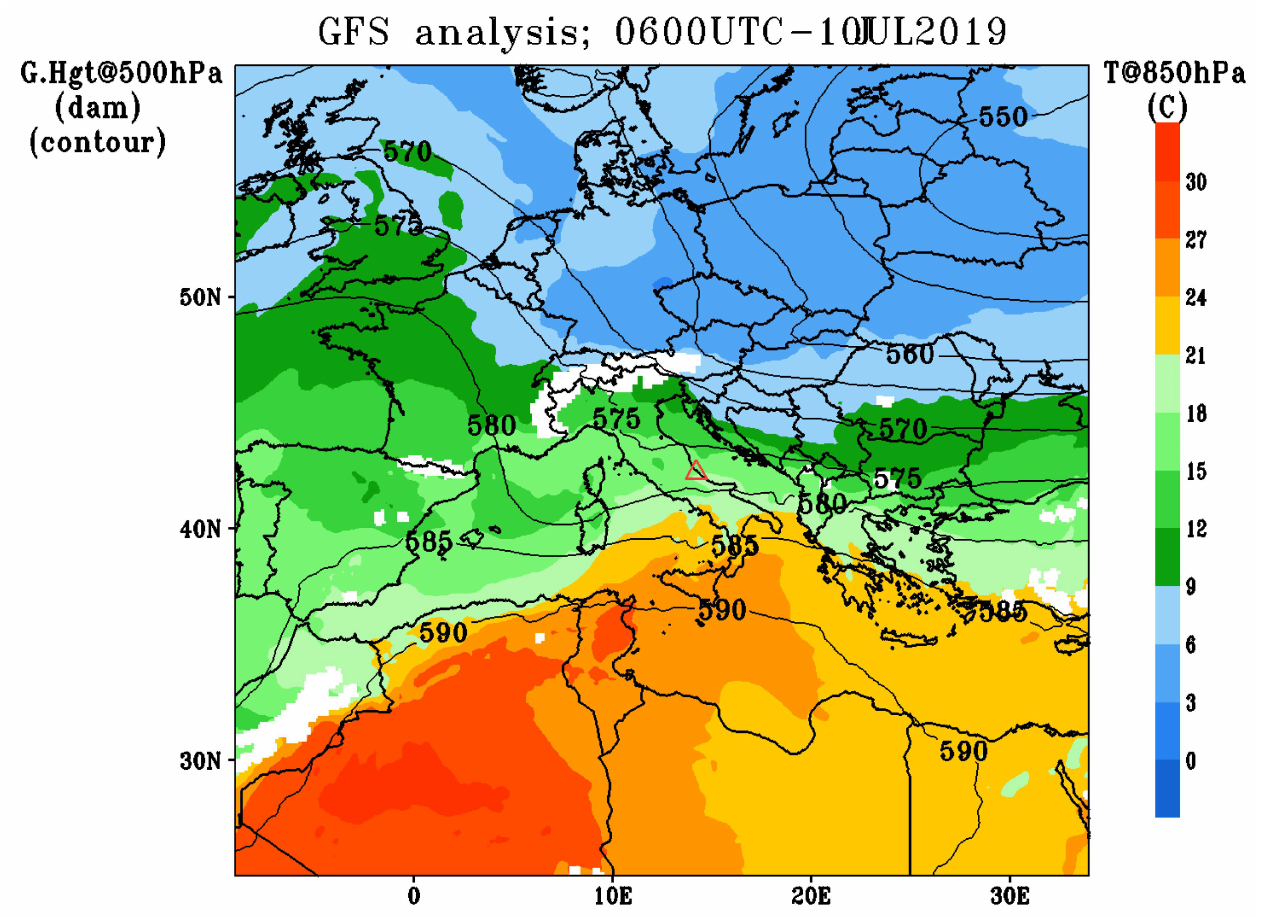
Figure 1. NCEP analysis of the temperature at 850 hPa and the geopotential height at 500 hPa at 06:00 UTC, 10 July